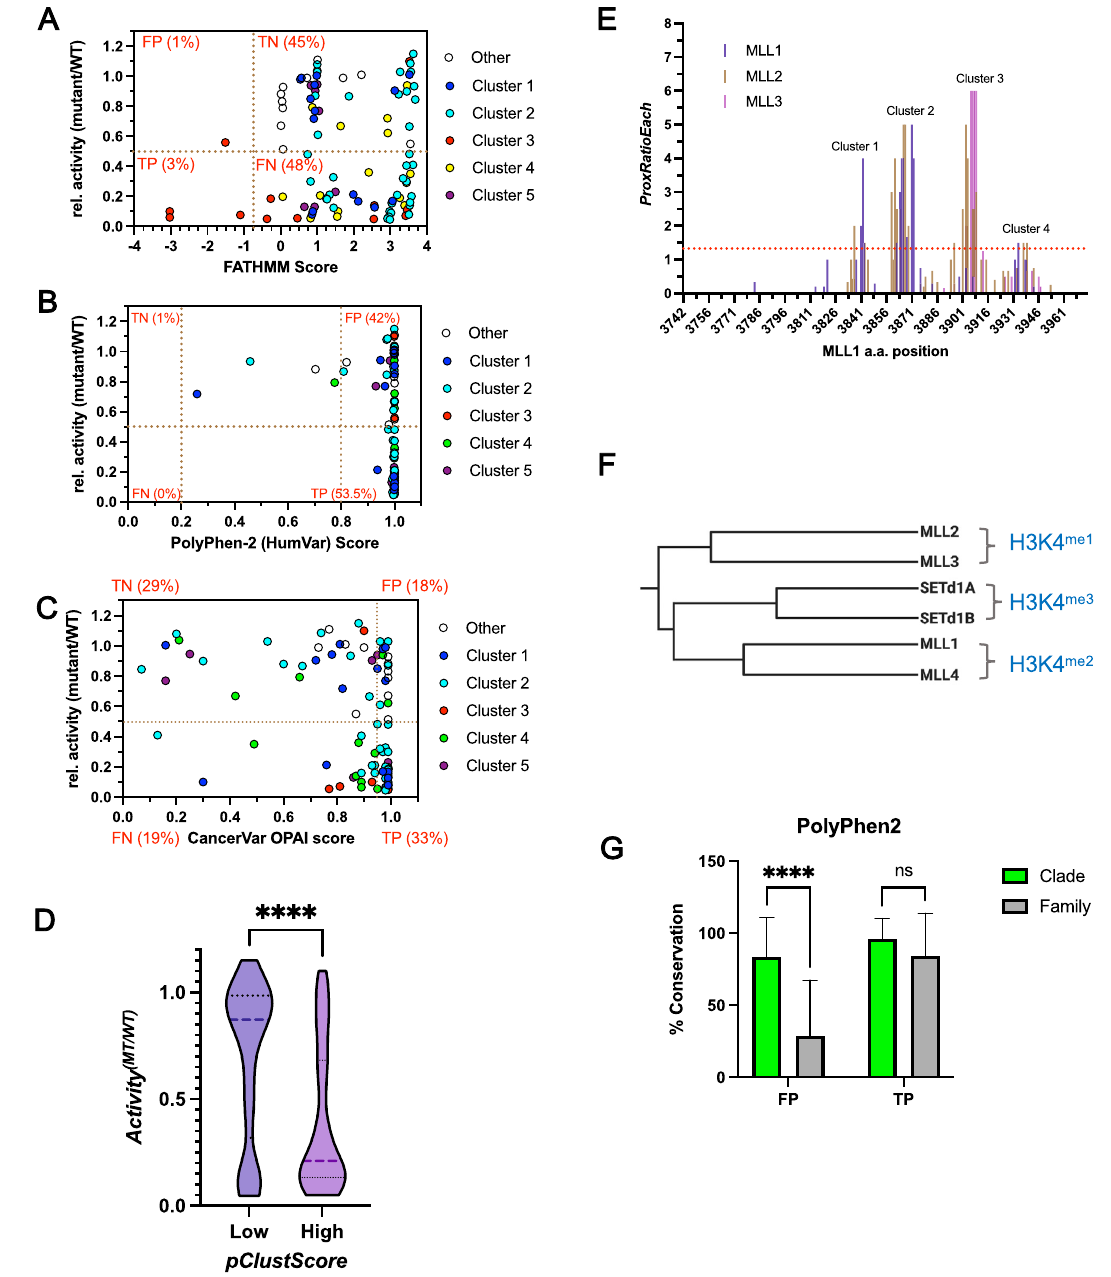
Figure 4. Comparison of predicted and in vitro phenotypes for cancer-associated missense variants of uncertain significance (VUS). ( A ) FATHMM scores vs. relative activity (mutant [MT]/wild-type [WT]) of VUS color coded by clusters. Clusters 1, 2, 4, and 5 have roughly equal density above and below 50% of wild-type activity (horizontal dotted line); vertical dotted line, FATHMM cancer default disease threshold ≤ − 0.75 (greater certainty that a mutation causes disease); white circles, 12 neutral mutations that did not fit in the 5 clusters; red dots, mutations corresponding to conserved “NHS” mutations in cluster 3 (motif essential for enzymatic activity). Three highly conserved cluster 3 residues were correctly called as true positives (TPs), but FATHMM lacked sensitivity to call the remaining cluster 3 loss-of-function variants despite similar activity loss. ( B ) PolyPhen-2 scores vs. relative activity of VUS. Vertical lines, PolyPhen-2 default disease thresholds: > 0.8 “probably damaging”, 0.2 to 0.8 “possibly damaging”, < 0.2 benign). ( C ) CancerVar OPAI scores vs. relative activity of VUS. Vertical line,default threshold (< 0.95) for variants with uncertain probability of oncogenicity. ( D ) Violin plot of mean activity differences between VUS with low (< 1.5) or high (> 1.5) parallel cluster scores ( pClustScore ). Significance was from 2-tailed unpaired t-tests. Dashed line, median; dotted lines, upper and lower quartiles. ( E ) Variant ProxRatioEach scores showing proximity of adjacent missense mutations in each protein, plotted as a function of amino acid position using Mixed Lineage Leukemia (MLL) 1 numbering. ( F ) Clustal Omega phylogenetic cluster analysis of human SET1/MLL proteins shows three clades diverged in product specificity (me1, 2, 3 is degree of methylation) 33 . ( G ) Comparison of family vs. versus clade conservation scores in PolyPhen-2 false-positive (FP) and true-positive (TP) amino acid positions. Two-way ANOVA compared means within groups. ****P < 0.0001; ns, P >